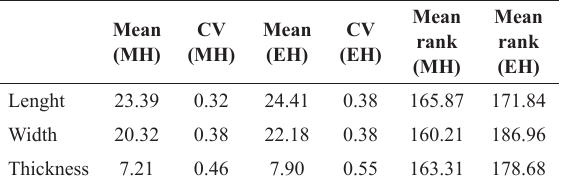
Mean, Coefficient of Variation (CV) and mean rank of core length, width and thickness from Middle Holocene (MH, n = 60) and Early Holocene (EH, n = 19).